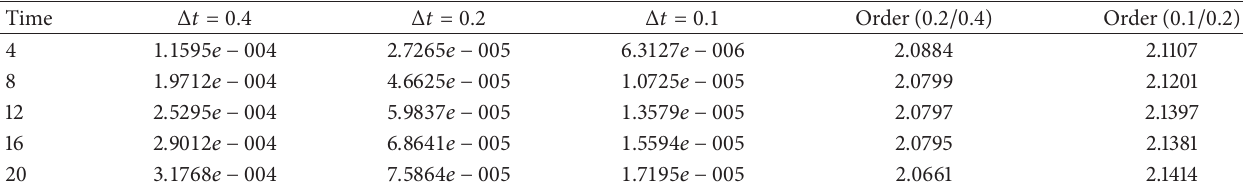
Table 5: Convergence order and error in 𝐿 ∞ norm for 𝑞 of time with ℎ = 0.125 and 𝑐 = 0.1 . Time